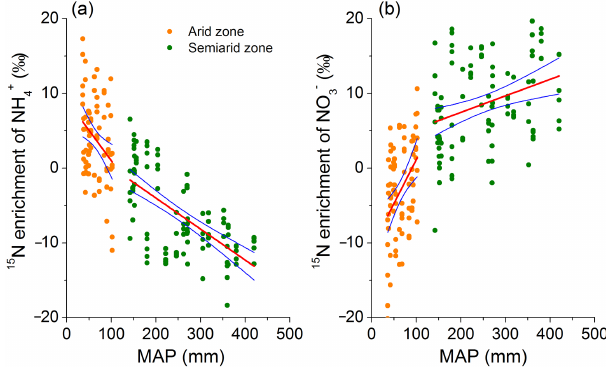
Figure 3. The relative 15 N enrichment of soil NH + in the figures were calculated as the difference between δ 15 N of bulk soil N and NH + and between δ 15 N of soil NH + 4 respectively. The significant ( P< 0 . 05) trend is shown with a re- gression line (red) and 95% confidence intervals (blue). At each site n =